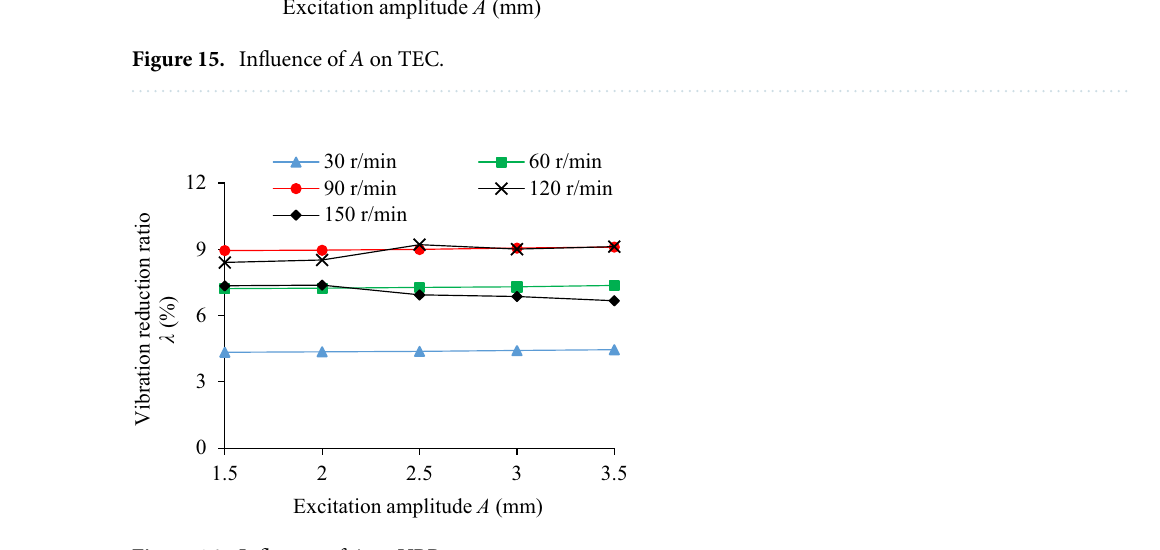
Figure 16. Influence of A on